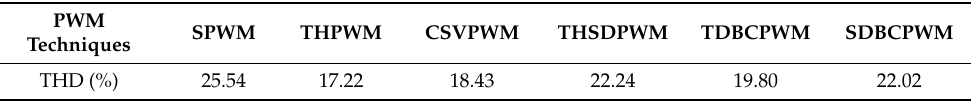
Table 2. Inverter line voltage total harmonic distortions (THDs) for different existing switching techniques.